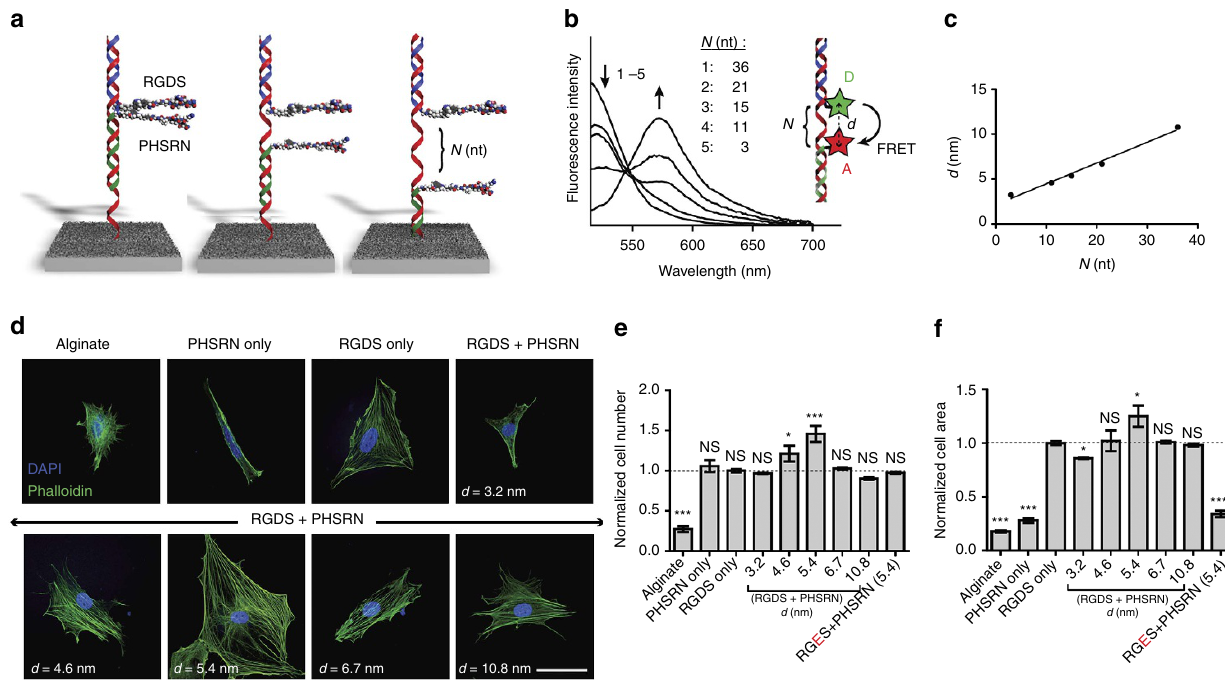
Figure 3 | Synergy between RGDS and PHSRN. ( a ) DNA surface strands with variable spacer regions were used to tune the distance between the peptide signals RGDS and PHSRN. ( b ) Fluorescence resonance energy transfer traces for DNA constructs modified with donor ( D ) and acceptor ( A ) dyes to probe the distance between them. ( c ) Relationship between N and the distance d as determined by FRET. ( d ) Confocal microscopy images of cells on indicated surfaces; staining for actin (phalloidin, green), and nuclei (DAPI, blue) reveals the cytoskeletal organization and cell nuclei, respectively. Scale bar: 50 m m, relevant to all images. ( e ) Normalized cell number and area ( f ) of fibroblasts on the surfaces indicated relative to the RGDS-only value; n ¼ 3. (* P o 0.05; *** P o